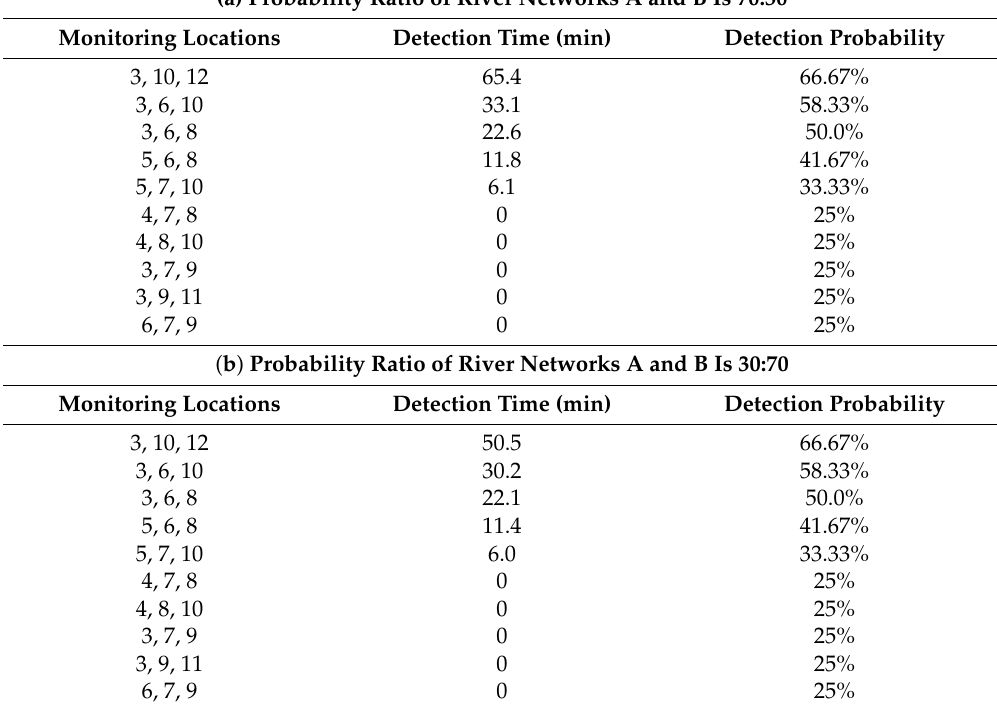
Table 7. Optimal deployment solutions for bidirectional water flows with a detection threshold of 0.01